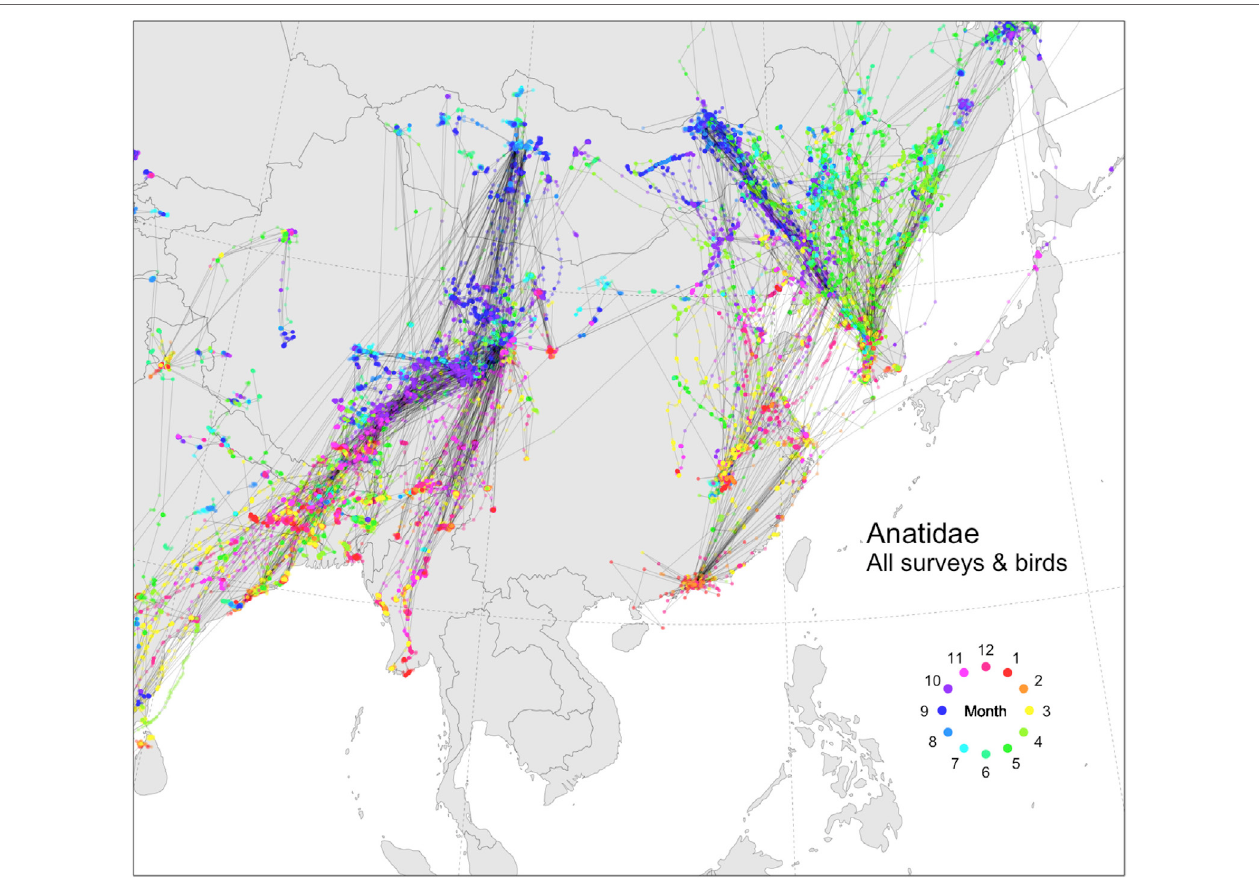
Figure 2 | Tracks of wild Anatidae in and around China, colored by month (524 birds, 19 species, from 2006 to 2017, USGS/FAO/KoEco/APQA/NIER surveys). Anas penelope ( n = 33), Anas acuta ( n = 50), Anser indicus ( n = 98), Anas strepera ( n = 17), Tadorna ferruginea ( n = 51), Anas crecca ( n = 20), Anas querquedula ( n = 16), Anas clypeata ( n = 19), Anser anser ( n = 2), Anas platyrhynchos ( n = 98), Anas poecilorhyncha ( n = 29), Anas formosa ( n = 2), Anas falcata ( n = 5), Netta rufina ( n = 1), Anser cygnoides ( n = 46), Cygnus cygnus ( n = 11), Cygnus columbianus ( n = 2), Anser albifrons ( n = 22), Anser fabalis ( n = 2). The data presented here were collected according to handling and marking procedures approved by the USGS Patuxent Wildlife Research Center Animal Care and Use Committee and the Animal and Plant Quarantine Agency ethical committee. The different datasets are described in the Movebank database